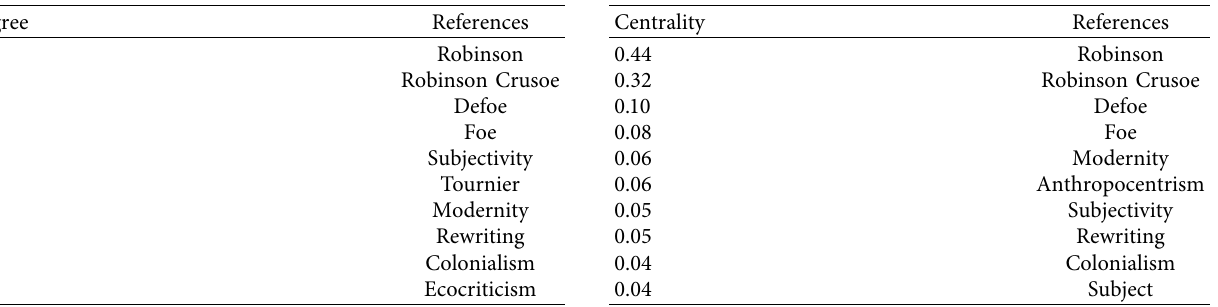
Table 9: Top 10 keywords by the